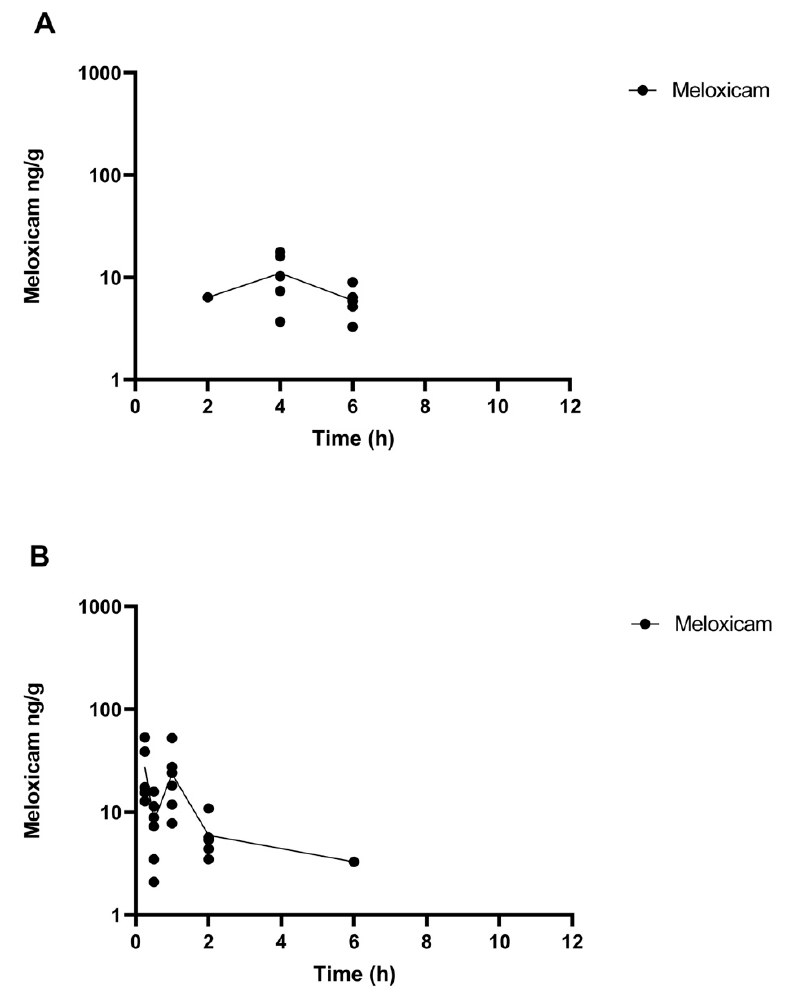
Figure 3. Mean ± SEM parent drug concentration in tissue after administration of a single dose of meloxicam (1 mg/kg) orally ( A ) or intramuscularly ( B ) (n = 6) from 0 to 12 h post-administration in tilapia.